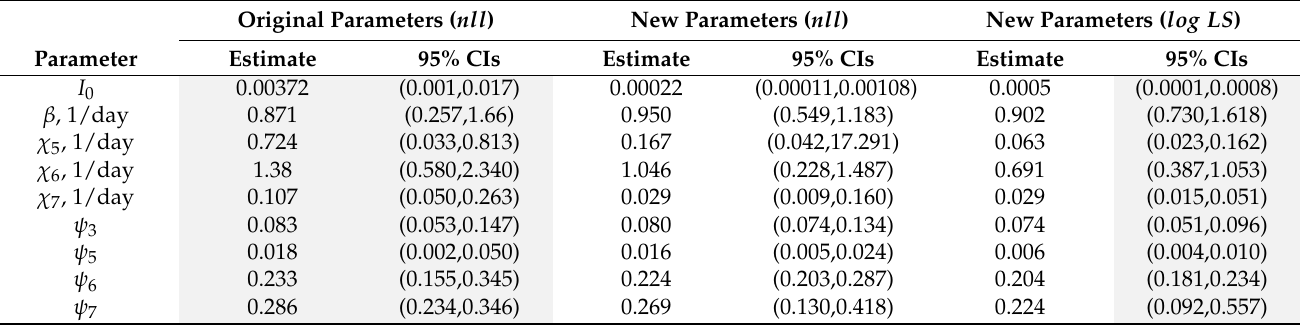
Figure 3. Previously published parameter estimates in Tromas et al. [14] do not provide a reasonable description of the data. We simulated basic mathematical model for viral spread in plants developed by Tromas et al. [14] (given in Equations (1)–(3) and Figure 1A) using parameter values provided in the original publication (solid lines), or fitted the model to the data using binomial distribution-based likelihood method (Equation (29), dashed lines). Data for the fraction of infected cells are shown by markers for leaf 3 ( A ), leaf 5 ( B ), leaf 6 ( C ), and leaf 7 ( D ) with red horizontal lines denoting average fraction of infected cells per time point. Parameters for the model fits are shown in Table 1. Table 1. New parameter estimates for the basic mathematical model of virus spread in plants. We list the parameter estimates and 95% confidence intervals (CIs) of the basic mathematical model of viral spread in plants (Equations (1)–(3)) as provided by Tromas et al. [14] (“Original parameters ( nll )”) or by fitting the model to data in this work using using binomial distribution-based likelihood (“New parameters ( nll )”, Equation (29)) or using least squares with a logarithmic transform (“New parameters ( log LS )”, Equation (35)). Fits of the mathematical model for two sets of model parameters are given in Figures 3 and 4. Confidence intervals for best fit parameters were generated using bootstrap by resampling the data (for likelihood-based fits) or were provided by the routine minimize in from python library lmfit for least square-based fits (see Section 2 for more